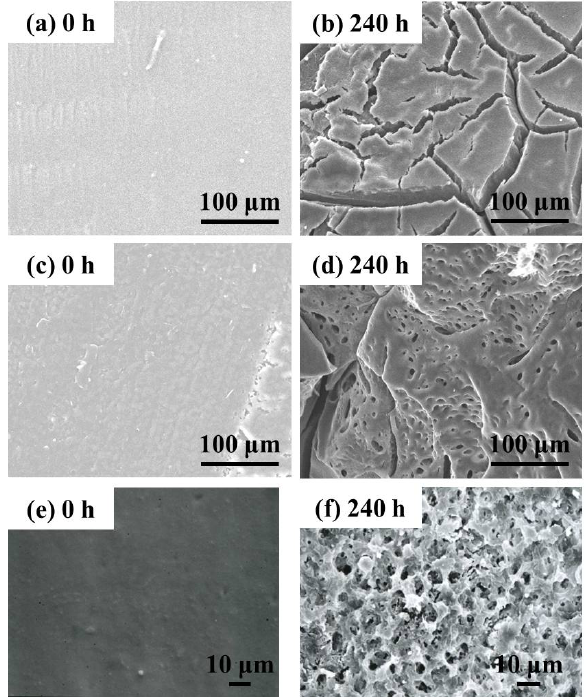
Figure 11. Typical SEM images of the surface and the cross section of Lait-X bulk ( a , b ) (surface); Lait-X bulk ( c , d ) (cross section); and linear polylactide (PLA) bulk ( e , f ) (surface) before and after enzymatic degradation for 240